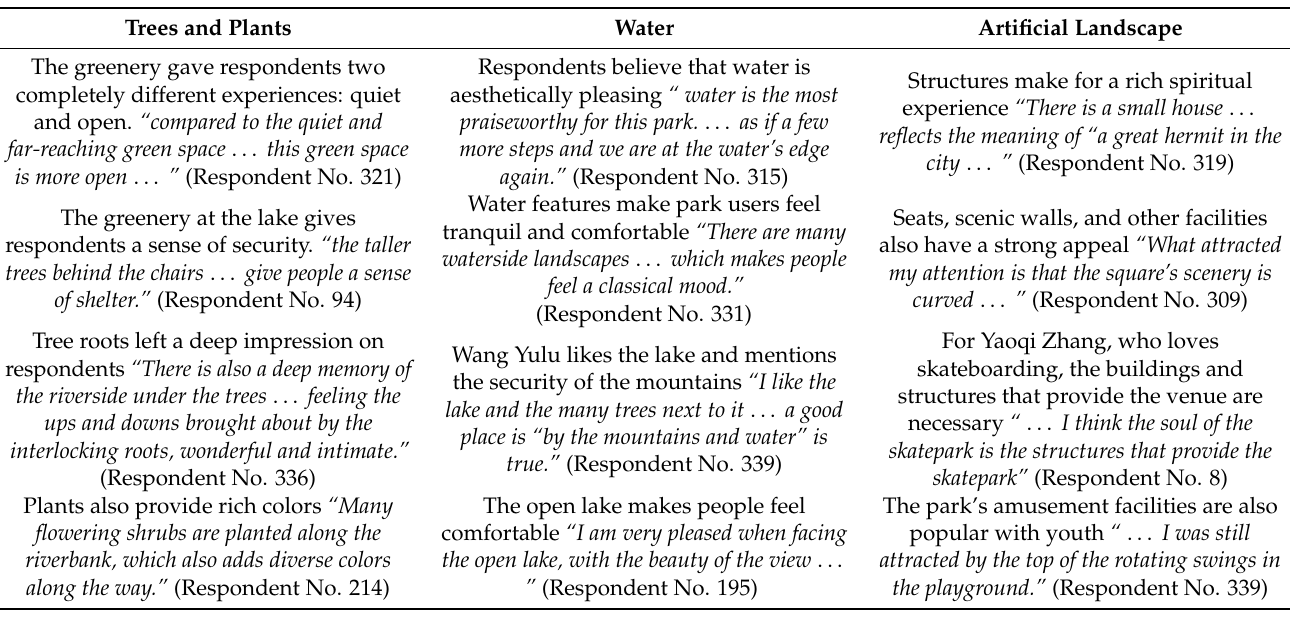
Table 5. Most common descriptions of landscape environment